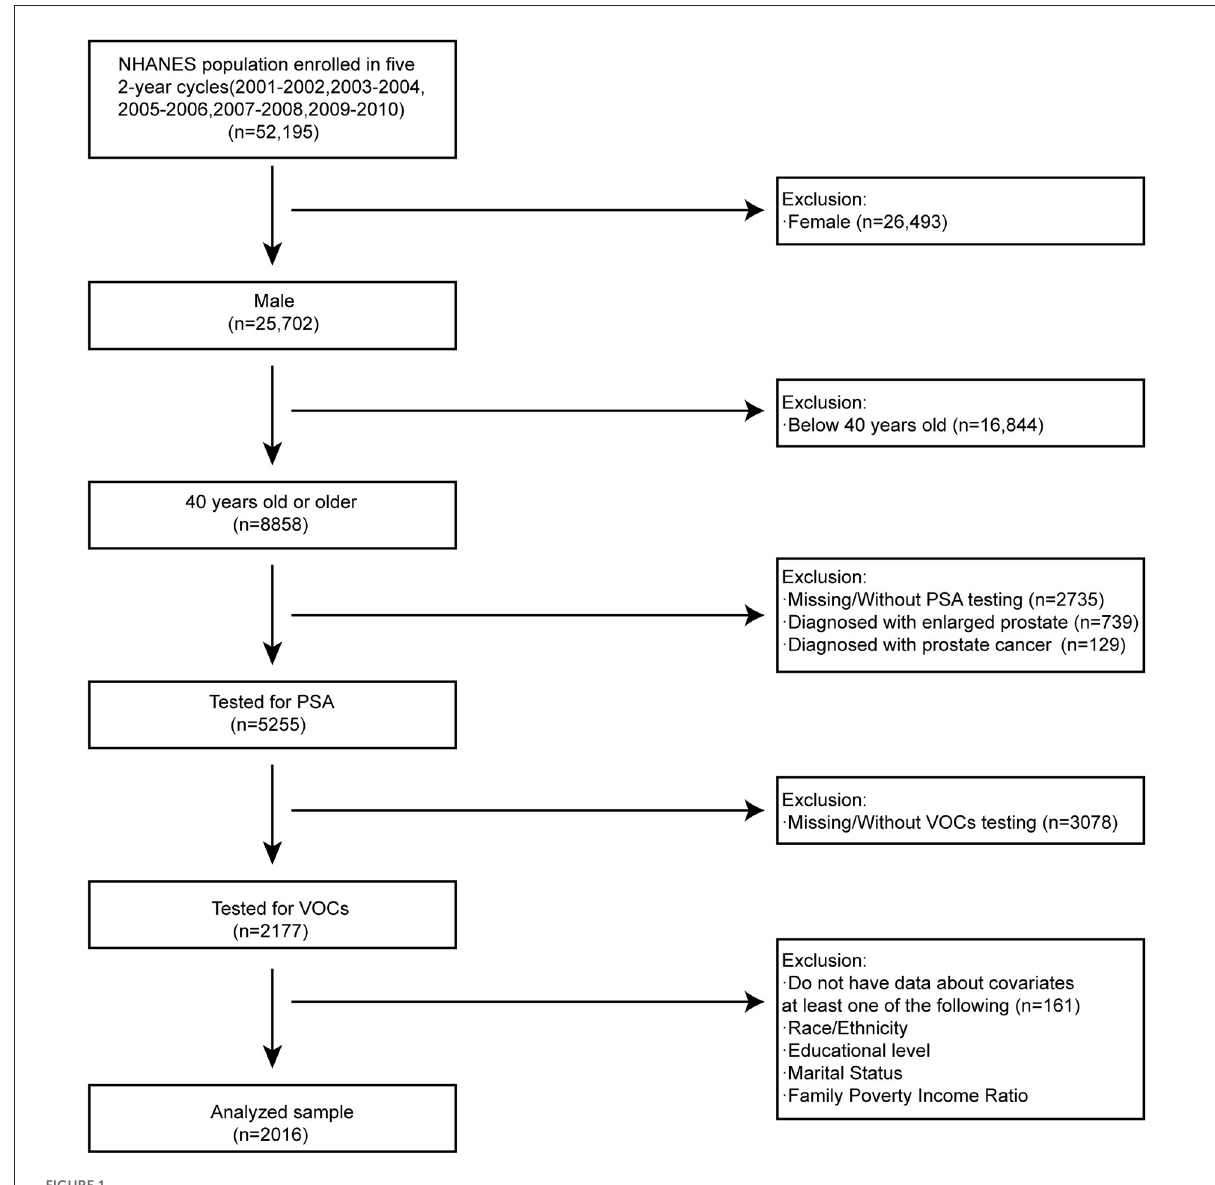
FIGURE1 Flowchart for selecting analyzed